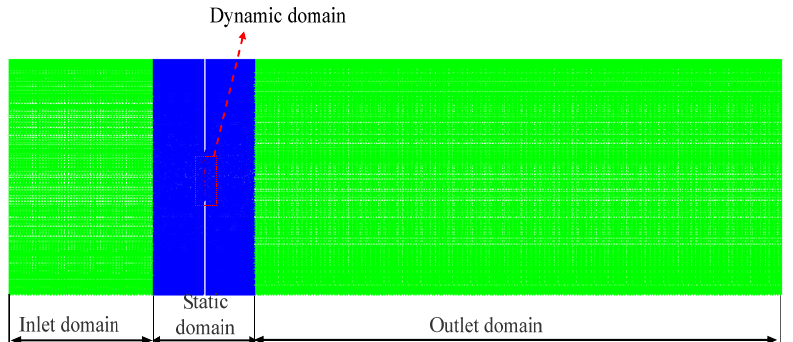
Figure 8. The mesh sketch of computing region distribution.